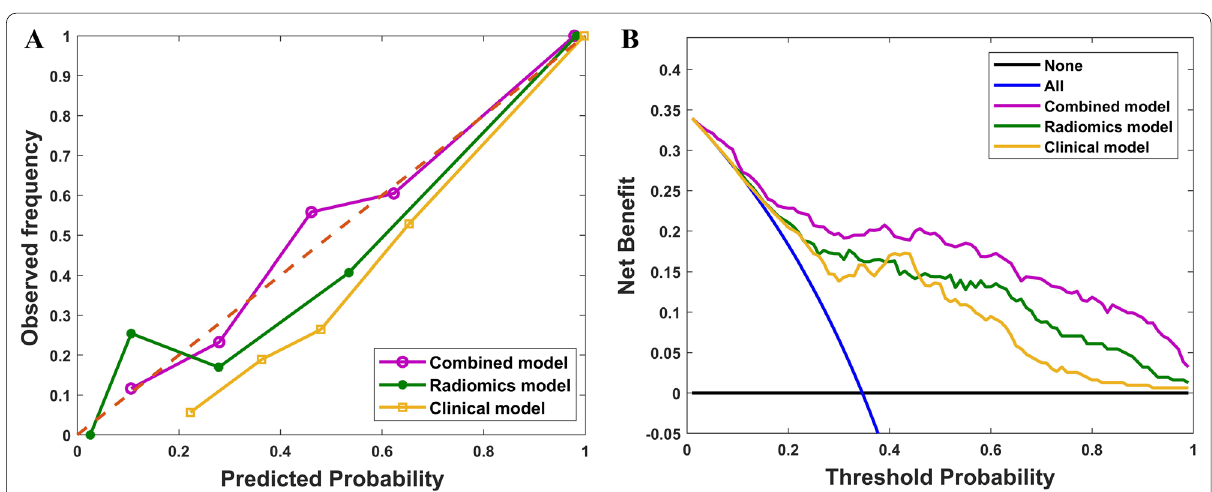
Fig. 6 a Calibration curve and ( b ) decision curve analysis of the combined model, radiomics model, and clinicoradiological model in the testing